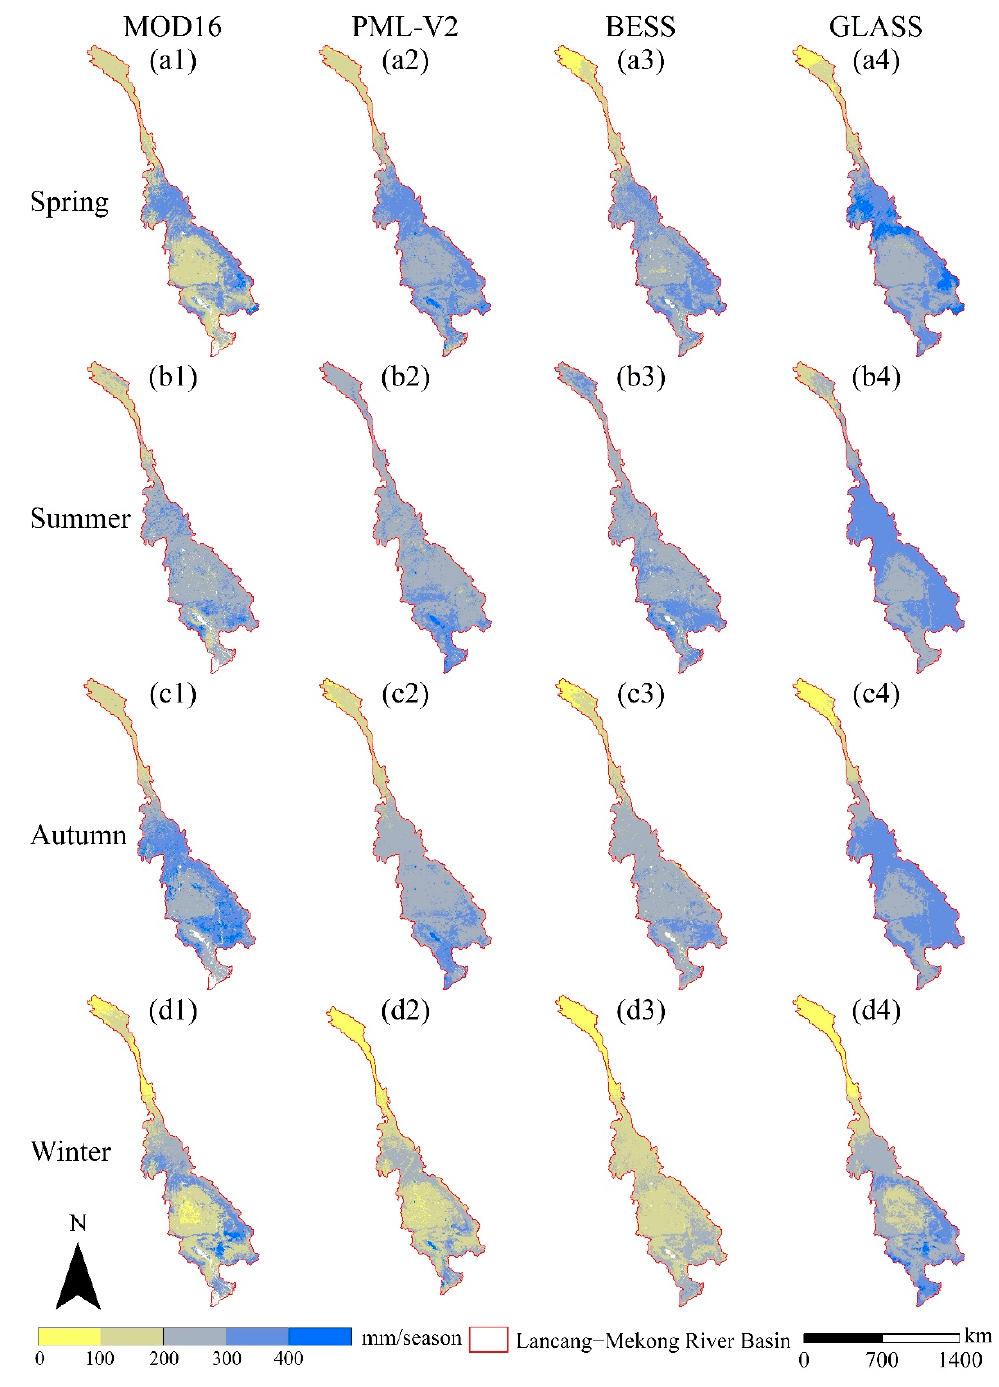
Figure 5. Spatial ET of multi-year seasonal average of the four products. ( a ), ( b ), ( c ) and ( d ) represent spring, summer, autumn and winter respectively, and 1, 2, 3, 4 represent MOD16, PML-V2, BESS and GLASS respectively.